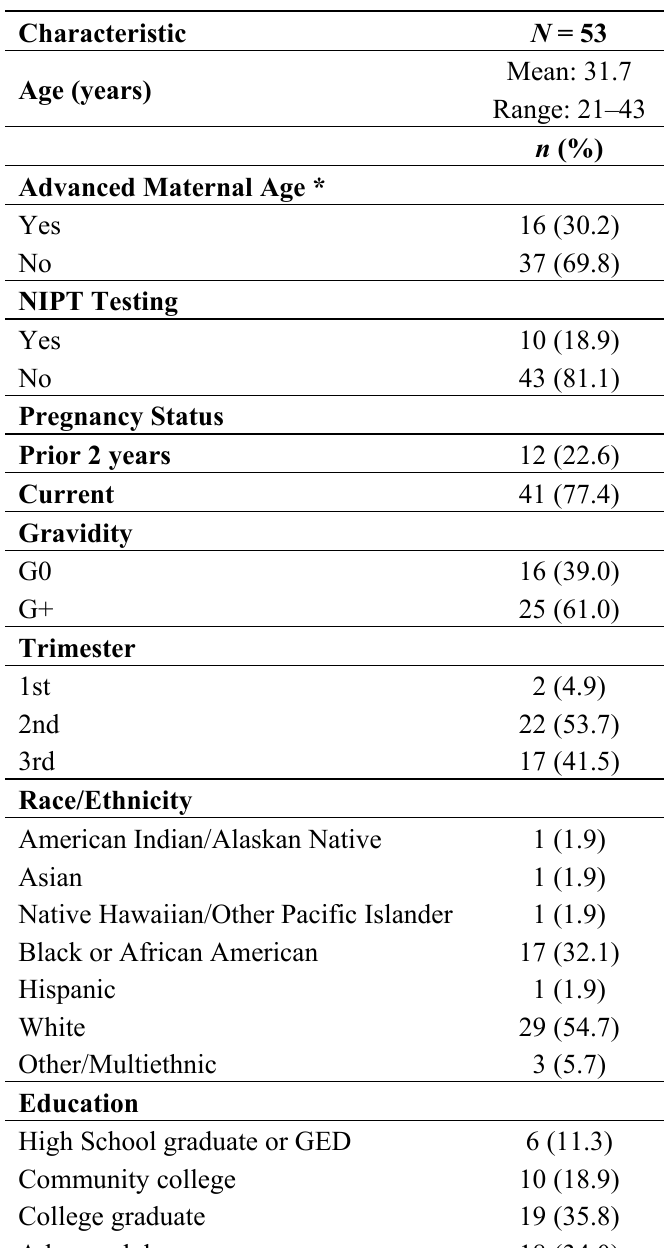
Table 1. Demographic characteristics of